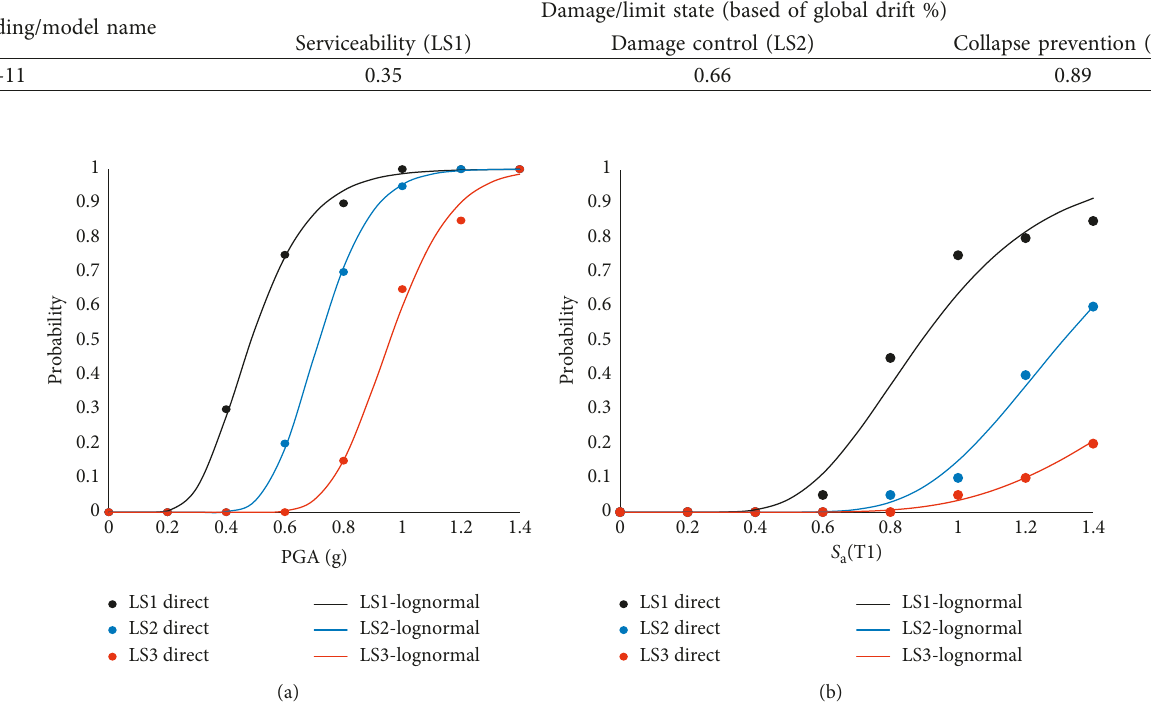
Table 5: Limit state criteria for the considered building typology.